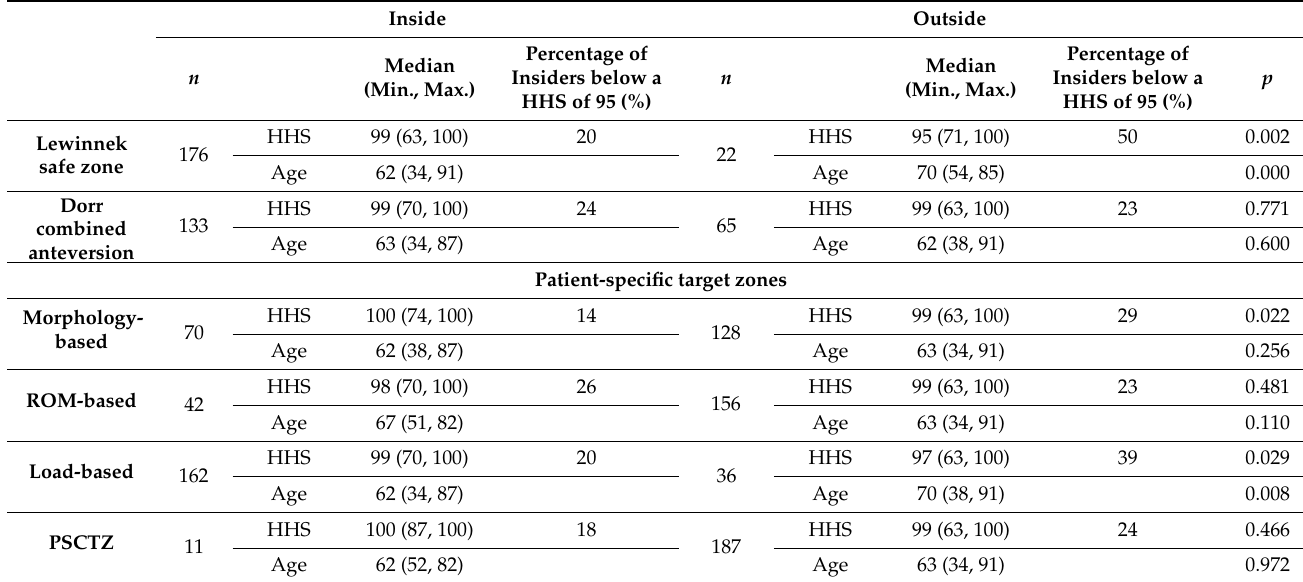
Table 1. Number of patients inside and outside the conventional and patient-specific target zones and their median HHS and age.